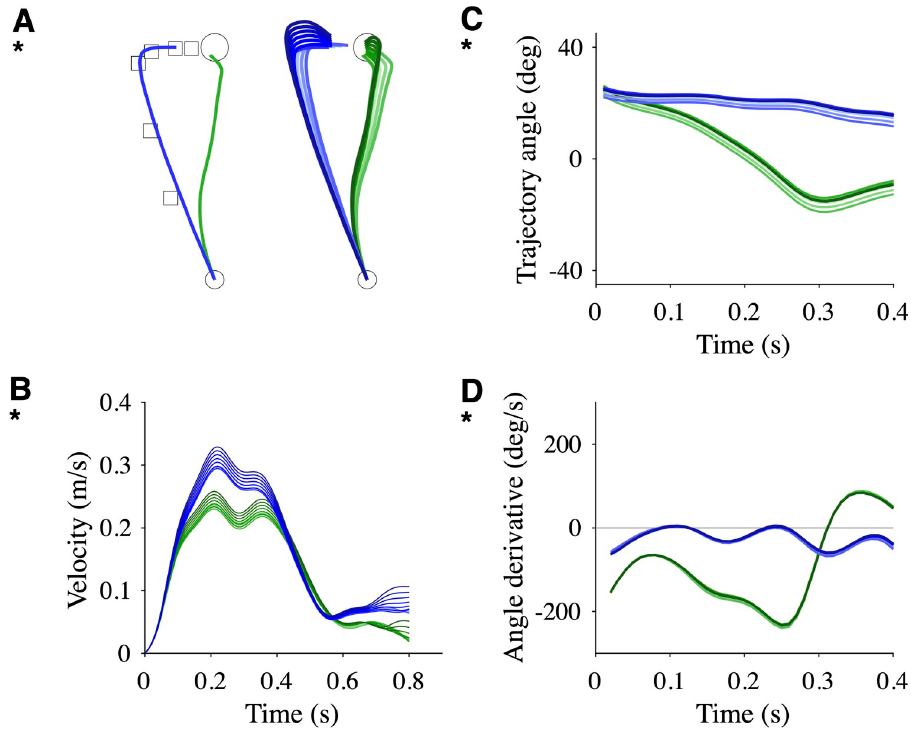
Fig 8. Simulations of the redirection model. A . ( left ) Adapted ( green ) and after-effect ( blue ) trajectories corresponding to a series of via-points ( squares ). ( right ) Multiple adapted and after-effect trajectories corresponding to variations of the series of via-points. B . Corresponding velocity profiles. C . Corresponding trajectory angles. D . Corresponding trajectory angle